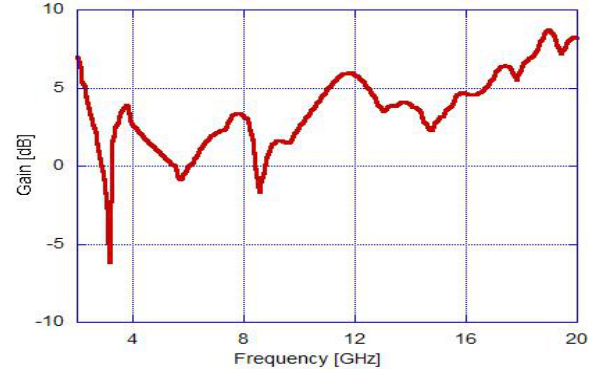
Figure 13: Simulated gain of the proposed antenna. Table 2: The gain values at individual